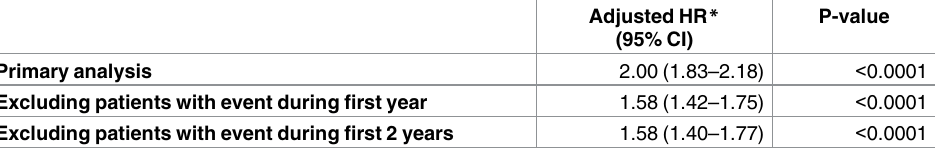
Table 3. Sensitivity analysis of the Cox regression model for major adverse